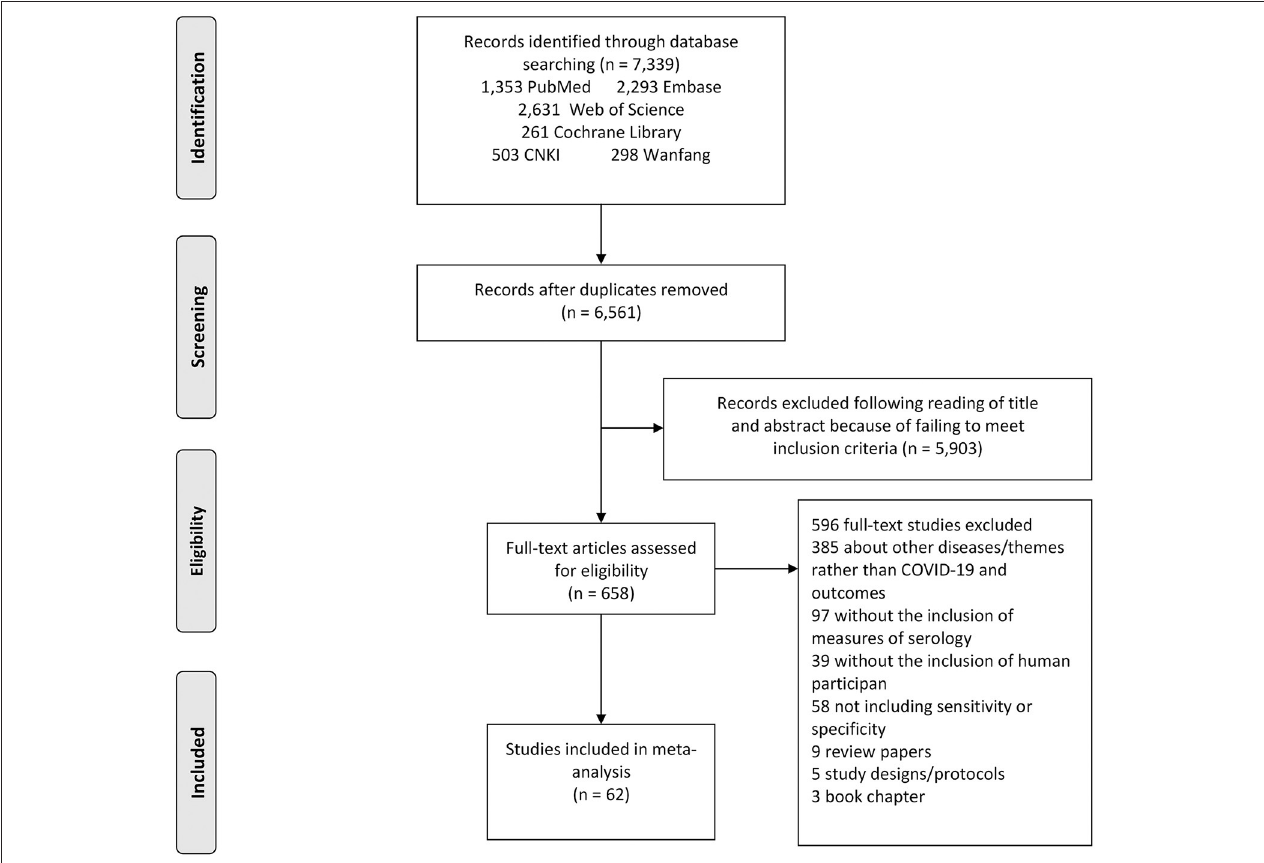
FIGURE 1 | Study selection flow chart. A Preferred Reporting Items for Systematic Reviews and Meta-Analyses (PRISMA) flow chart demonstrating the selection process of articles included in the analysis as well as in the qualitative